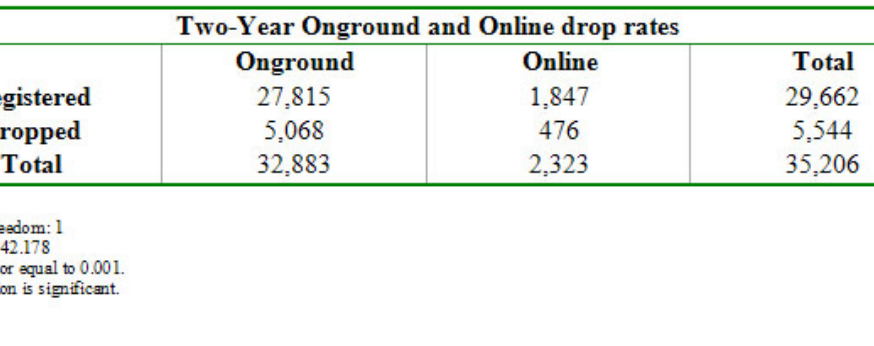
Table 4 : Comparison of online and onground persistence